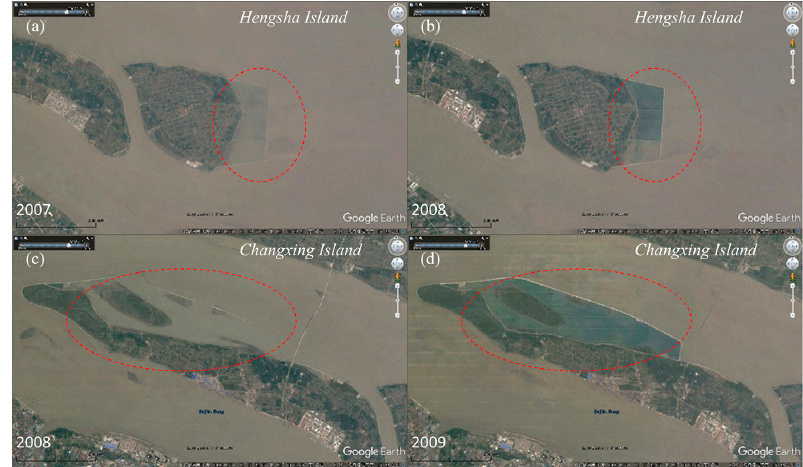
Figure 12. High-resolution images from Google Earth that illustrate the sharp changes in land area that occurred in 2007 and 2008. The first row ( a , b ) and the second row ( c , d ) show the land reclamation in Hengsha Island and Changxing Island, respectively (regions within red ellipses).